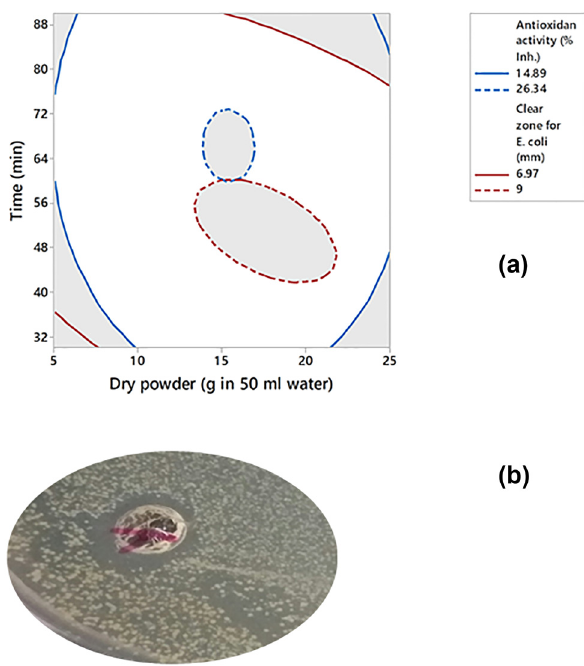
Figure 8: Overlaid contour plot of ZnO NPs as graphical optimization ( a ) . Created clear zone in the plates amended with E. coli ( b )